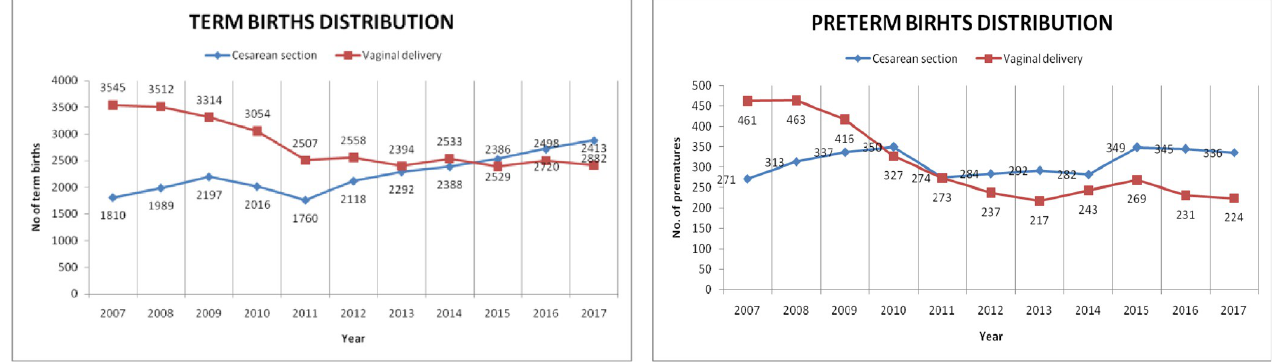
Fig 1. Distribution of preterm and term births delivered by CS vs VD, in one tertiary center, from January 1st, 2007, and December 31st, 2017.